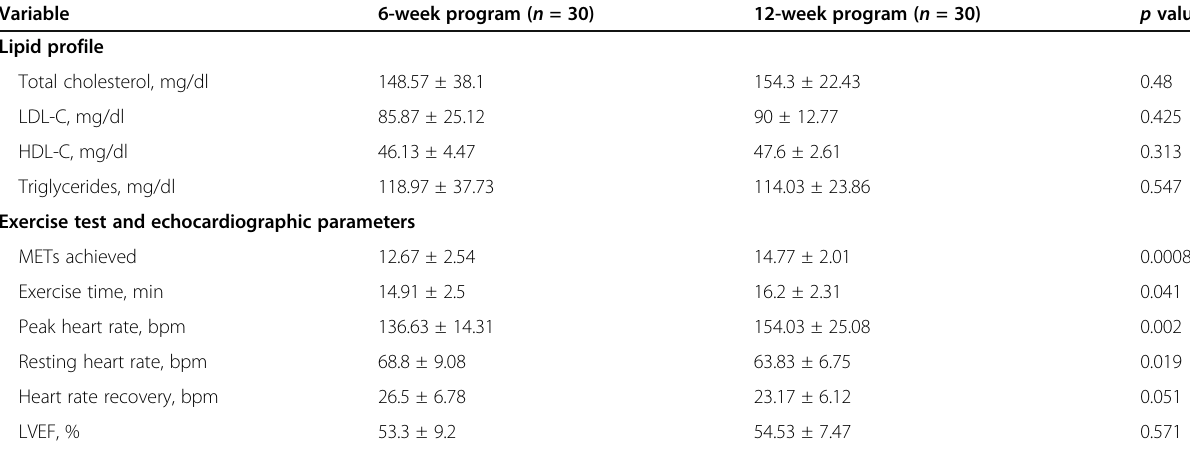
Table 2 Comparing both groups at the end of each program